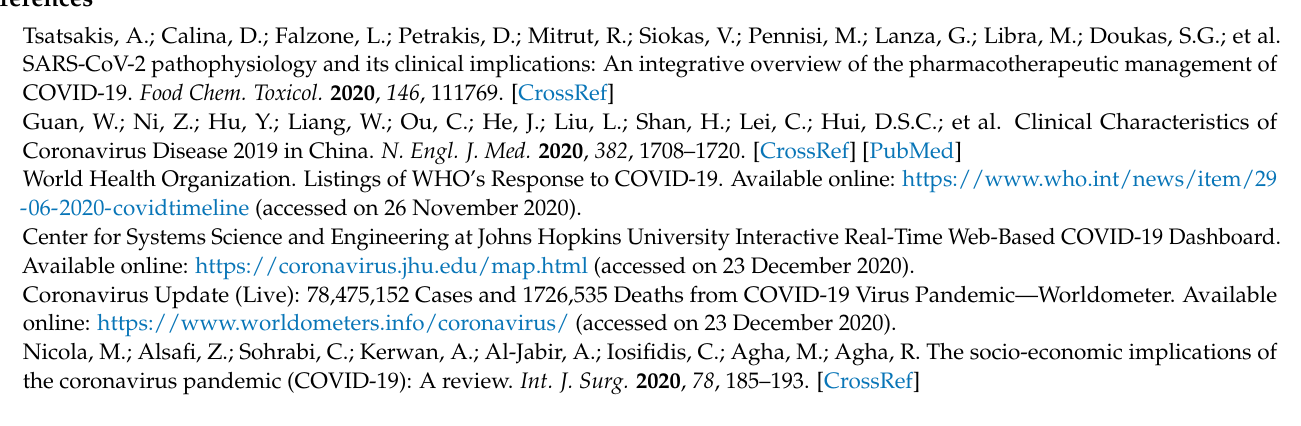
clustering of various biosamples based on transcriptomic signature changes upon SARS-CoV-2 infection, Figure S5: Selection of the relevant DEGs (detailed pipeline), Figure S6: Final list of consensus DEGs upon SARS-CoV-2 infection, Figure S7: Selection of the drugs (detailed pipeline), Figure S8: Distribution of 37 repurposable drug candidates with a potential to reverse transcriptomic signature upon SARS-CoV-2 infection based on their properties, Figure S9: Hierarchical clustering of 37 drug candidates based on molecular structure, Figure S10: PCA biplot demonstrating heterogeneity of 37 drugs in physicochemical space, Figure S11: Distribution of 37 drug candidates based on drug target properties, Figure S12: Hierarchical clustering of 37 drug candidates based on combined properties; Table S1: List of DEGs for each dataset separately (8 × ), Table S2: List of DEGs for each group of datasets separately (4 × ), Table S3: List of 636 DEGs common between A549-ACE2 and Calu-3, Table S4: List of significantly enriched pathways involved in SARS-CoV-2 infection, Table S5: Description of GO Biological Process categories for which DEGs were excluded, Table S6: Final list of 539 DEGs common between A549-ACE2 and Calu-3 after exclusion of “host defense against viral infection” genes, Table S7: Characterization of 37 drug candidates with a potential to reverse transcriptomic signature upon SARS-CoV-2 infection, Table S8: Target characterization of 37 drug candidates, Table S9: Physicochemical properties of 37 drug candidates, Table S10: Main drug target protein families distribution comparison for all FDA approved drugs and 37 drug candidates, Table S11: List of significantly enriched pathways regulated by 37 drug candidates, Table S12: Main categories of enriched pathways in overlap between pathways regulated by 37 drug candidates and pathways affected by SARS-CoV-2